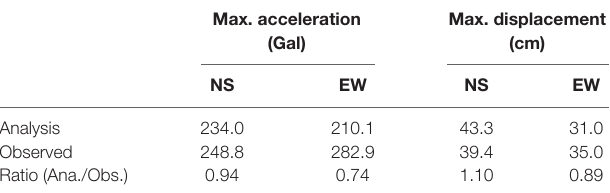
TaBle 6 | Maximum acceleration and displacement responses at 32F (3/11 main